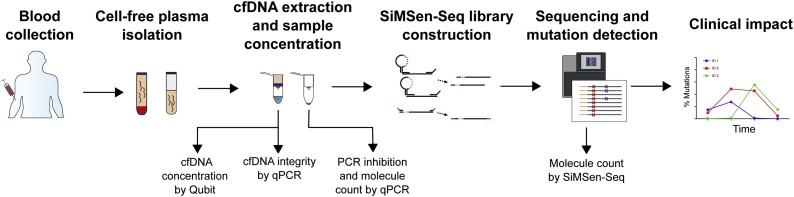
The workflow of liquid biopsy analysis. The quality controls steps applied in this study are indicated by vertical arrows.